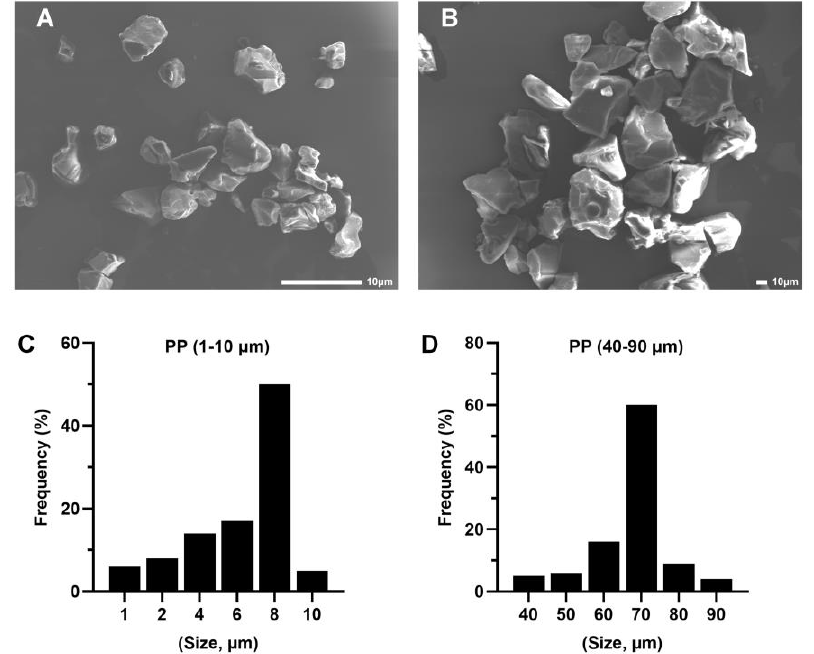
Figure 1. Characterization and scanning electron microscopy (SEM) images of polypropylene (PP) particles. ( A ) SEM images of 8 µ m PP particles (scale bar = 10 µ m) determined with a particle size analyzer ( C ). ( B ) SEM images of 70 µ m PP particles (scale bar = 10 µ m) determined with a particle size analyzer ( D ).